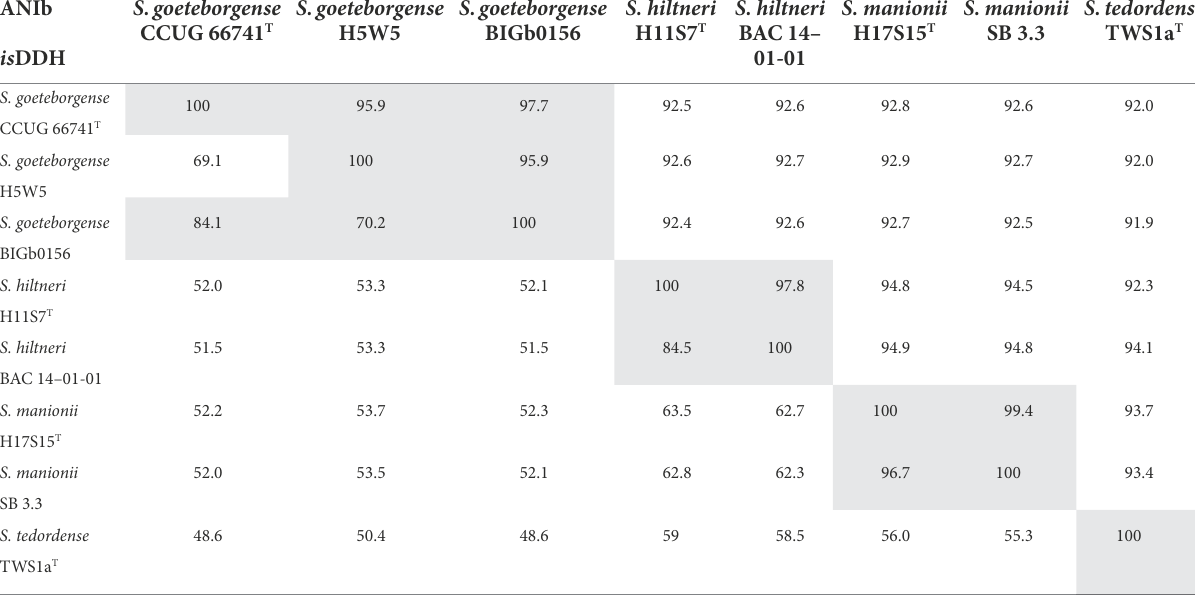
TABLE 1 Average Nucleotide Identity based on BLAST (ANIb – top right) and in silico DNA - DNA Hybridisation d 5 matrix ( is DDH – bottom left) percentage values for novel Scandinavium species and S. goeteborgense . ANIb is